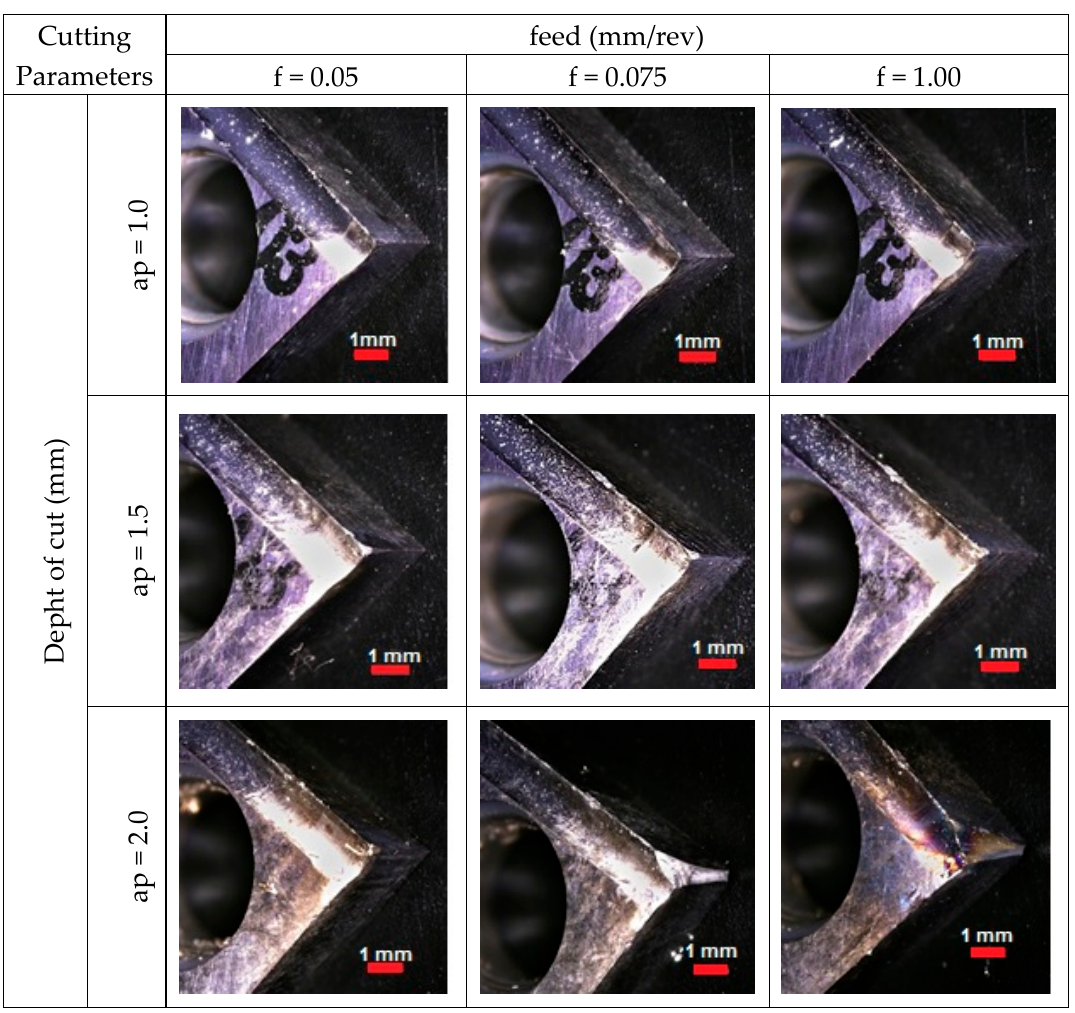
Figure 10. The wear of cutting edge.